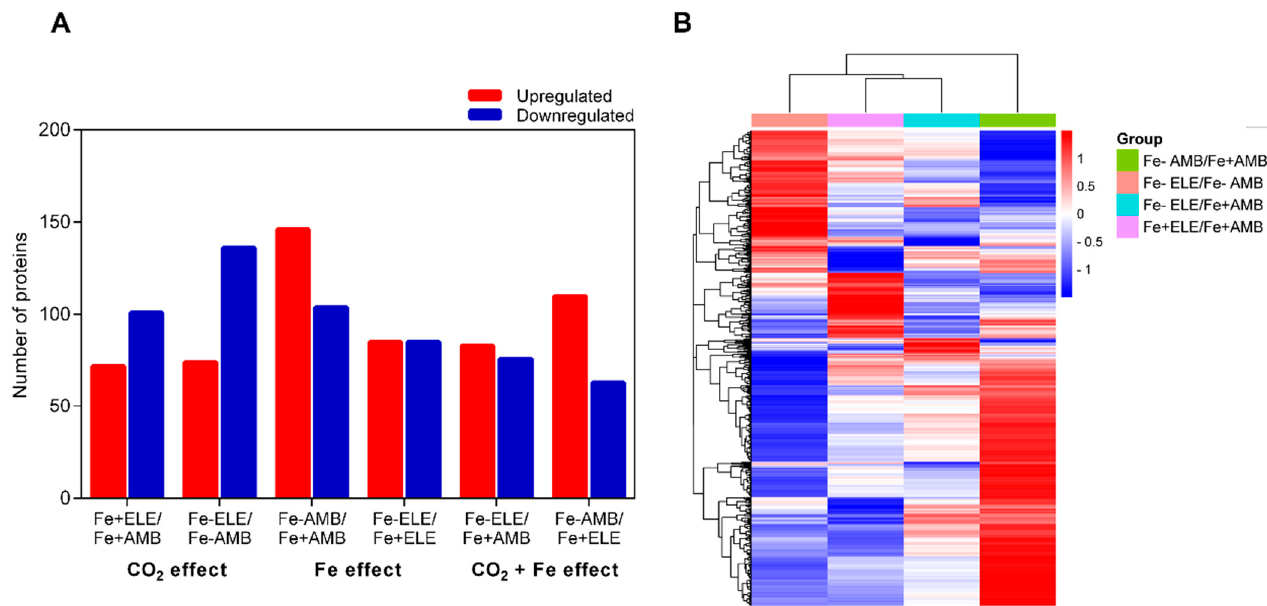
Figure 4. Soybean leaf proteome profiles under eCO 2 and Fe-limitation. ( A ) The number of upregu- lated and downregulated proteins in soybean leaf in response to eCO 2 and Fe-limitation; ( B ) Cluster analysis of all differently regulated proteins among different treatments. Fe+AMB, Fe-sufficient + aCO 2 ; Fe+ELE, Fe-sufficient + eCO 2 ; Fe-AMB, Fe-limitation + aCO 2 ; Fe-ELE, Fe-limitation + eCO 2 .